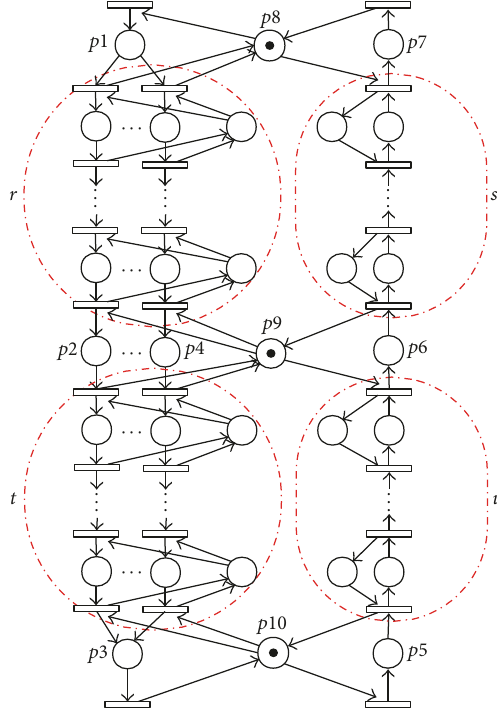
Figure 17: A 𝑘 -step look-ahead S 3 PR